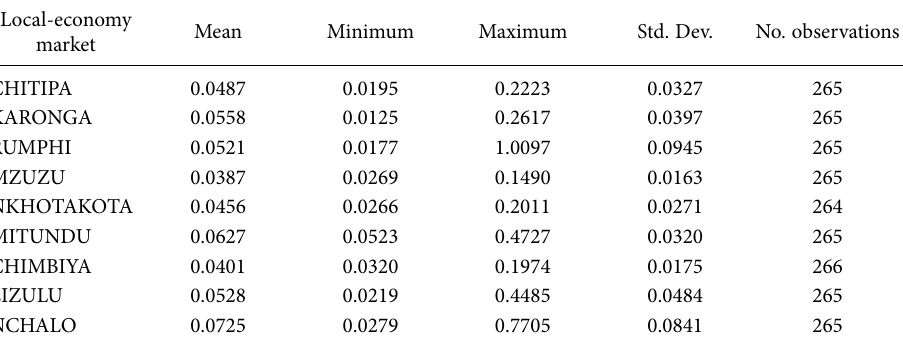
Table 5. Summary of the welfare cost of conditional price volatility by local-economy market (January 1991-March